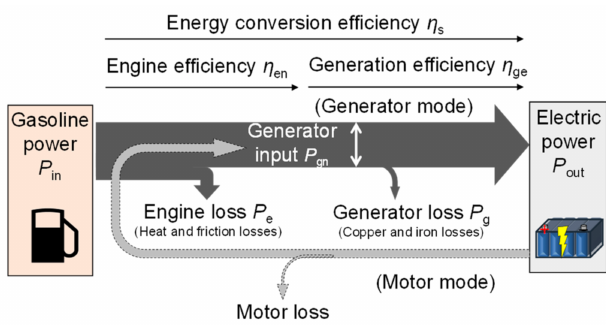
Figure 2. Energy flow of